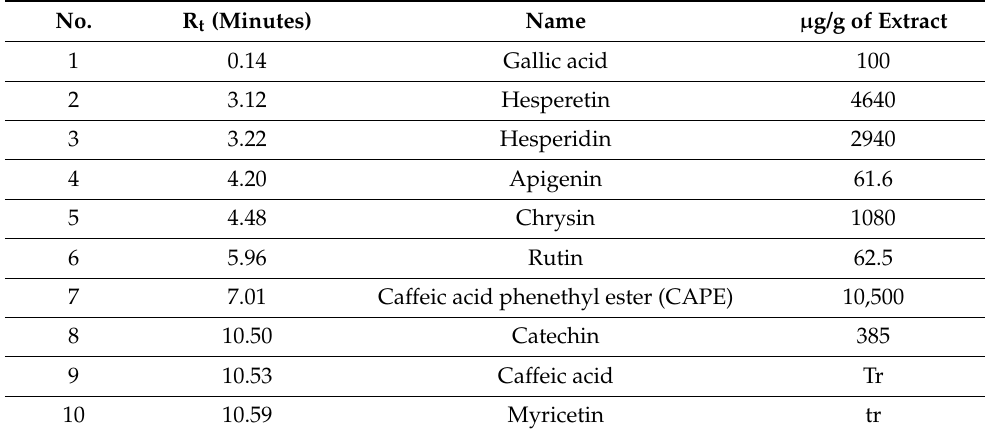
Table 4. LC-MS/MS analysis of the ethanolic extract of C. gileadensis .